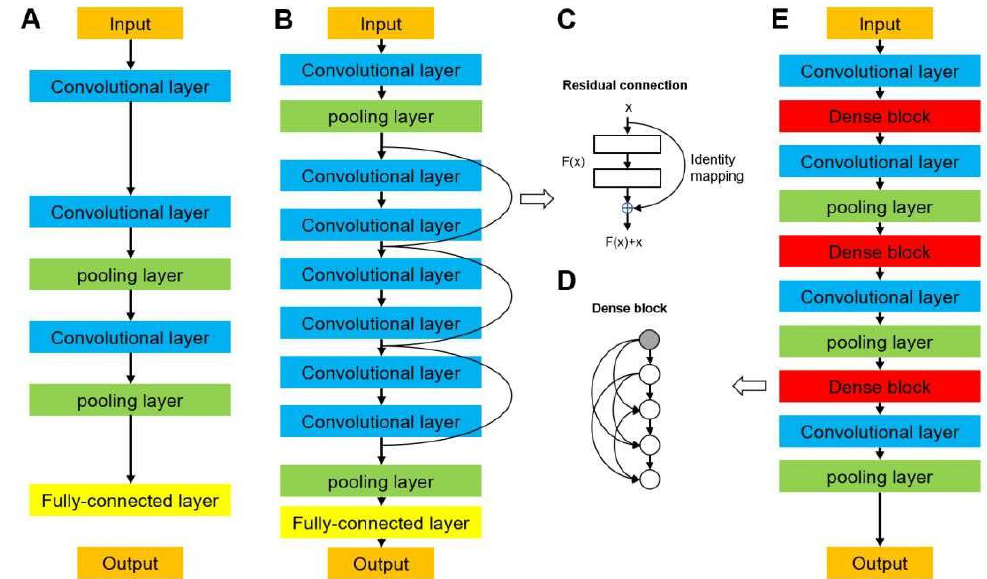
Figure 3. Network architectures of ( A ) a typical convolutional neural network, ( B ) a residual neural network (ResNet), and ( E ) a densely connected convolutional network (DenseNet). ( C ) Residual connection building block in ResNet. ( D ) Densely connected dense block in DenseNet.